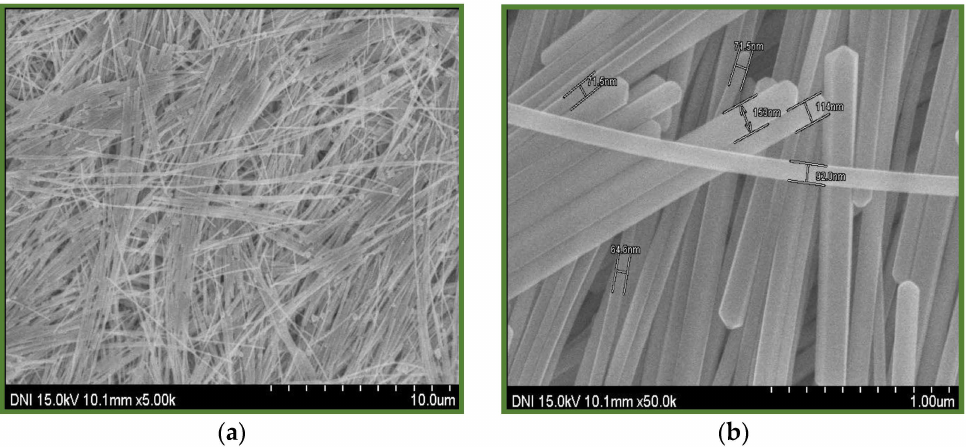
Figure 6. SEM images of AgNWs synthesized by continuous flow reaction of AgNWs utilizing tapered tubular type reactor: ( a ) low; ( b ) high resolution.